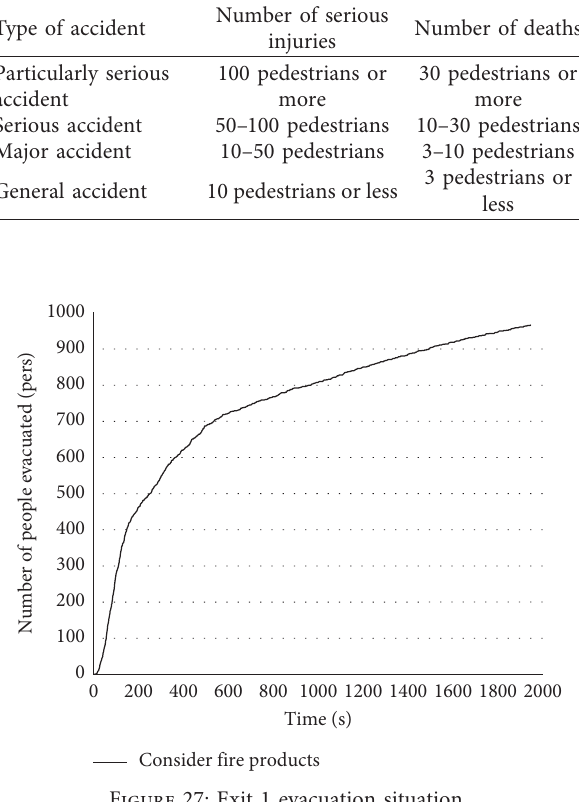
Figure 27: Exit 1 evacuation situation.